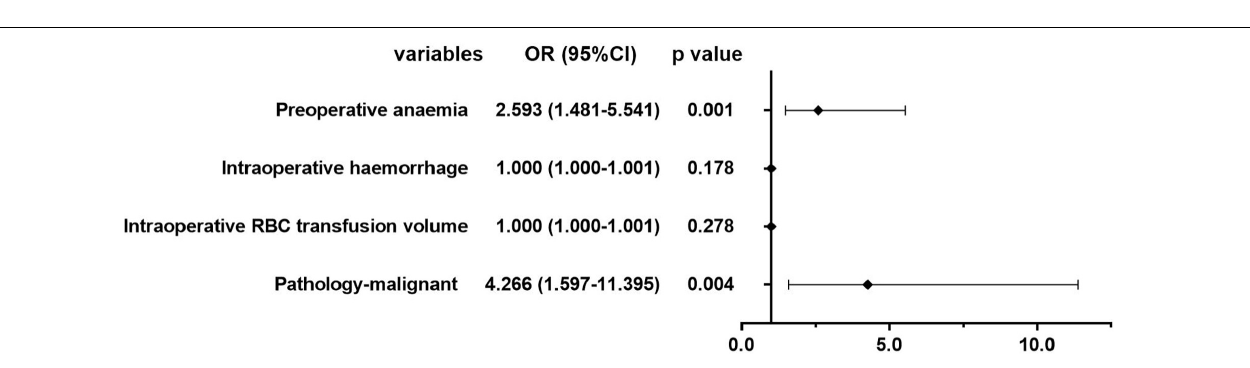
FIGURE 6 | Multivariate analysis of the risk factors of severe postoperative complications in patients after